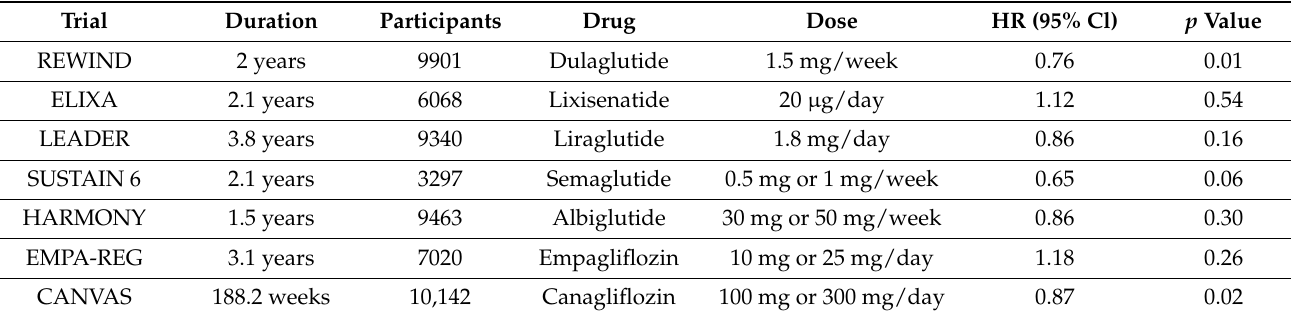
Table 1. Effects of glucagon-like peptide-1 receptor agonists (GLP-1RAs) and sodium-glucose transporter inhibitors (SGLT- 2is) on risk of fatal and non-fatal stroke in randomized controlled trials in patients with type 2 diabetes mellitus. Results are expressed as hazard ratio compared to